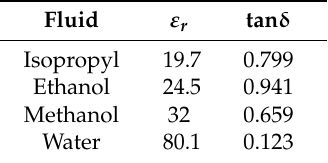
Table 1. Dielectric properties of the analysed fluids at room temperature.